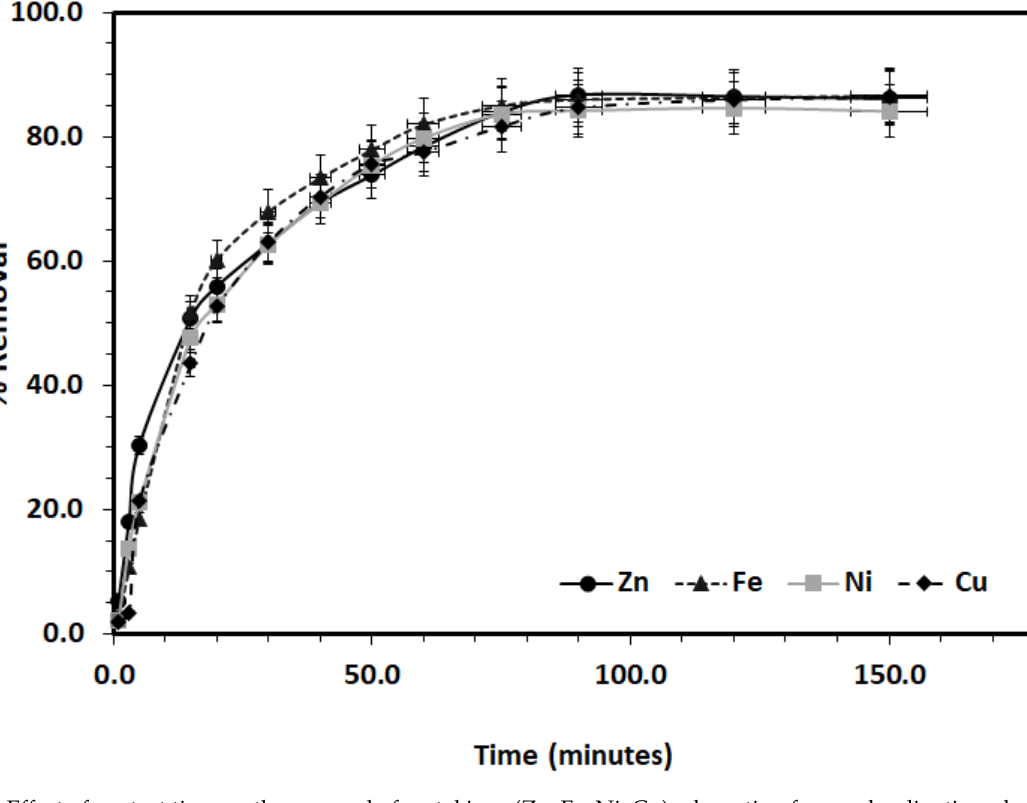
Figure 7. Effect of contact time on the removal of metal ions (Zn, Fe, Ni, Cu) adsorption from a desalination plant outfall brine discharge by HS nanoclay. (Experimental conditions: 60.0 mL solution, pH 8.0, 150 mg dosage, and 298 K).